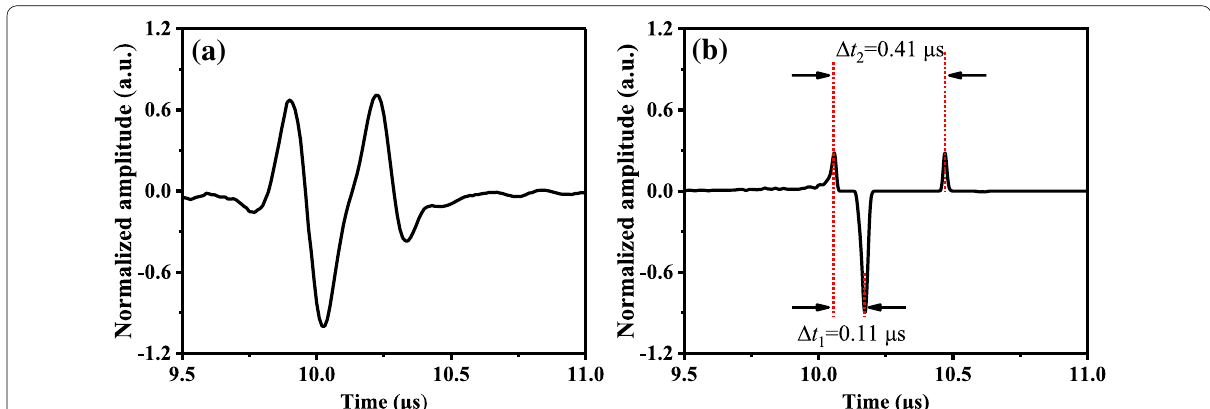
Figure 8 A-scan signals corresponding to the defect in different experimental reconstructed images: ( a ) in the image by conventional SAFT, ( b ) in the image by Sparse-SAFT